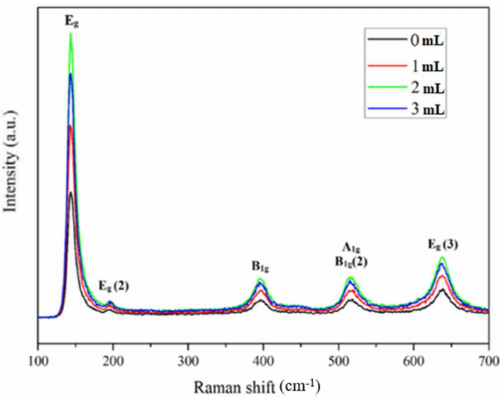
Figure 8. Raman spectra for for the mixed Acac (0, 1, 2, and 3 mL) with a TiO 2 mesoporous layer, corresponding to Figure 6.